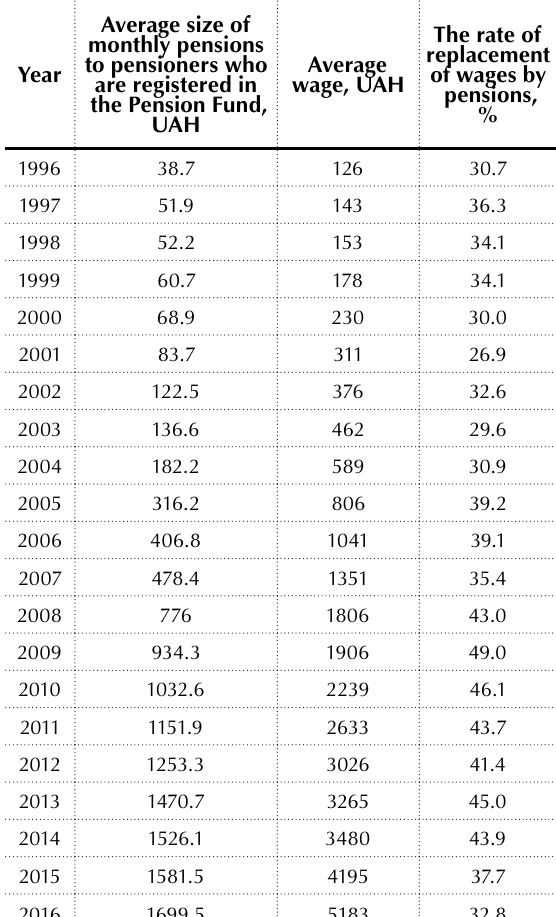
Table 1. Average monthly pensions, average